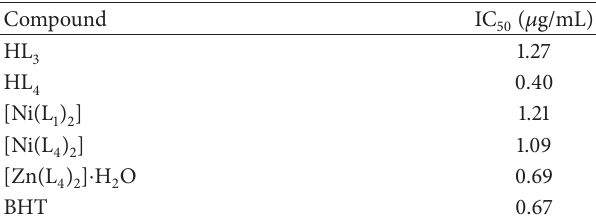
Table 7: IC values ( 𝜇 g/mL) of DPPH radical scavenging activity 50 of ligands and their metal complexes.